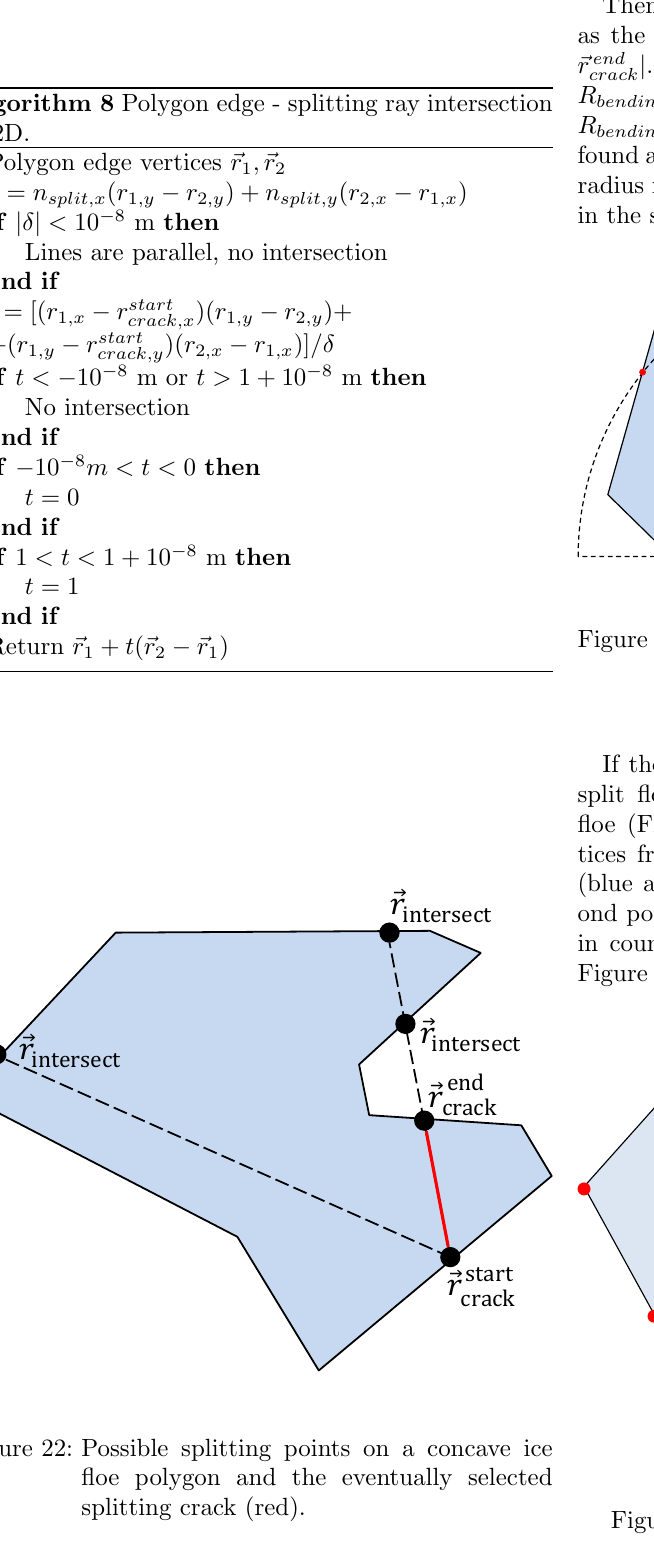
Figure 24: Generation of the split floe